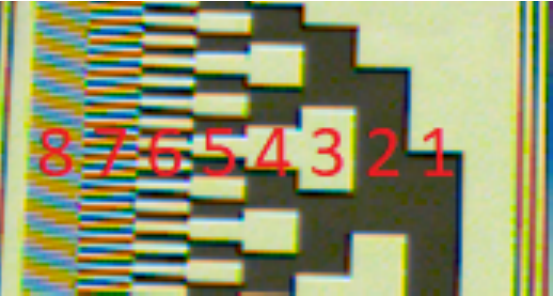
Figure 10. Resolution test